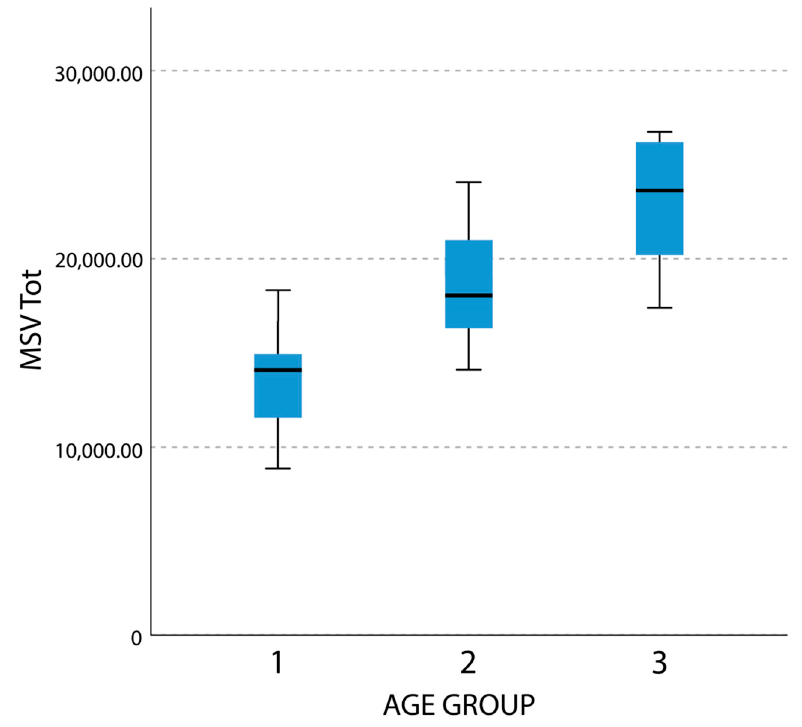
Figure 4. Boxplot representing total maxillary sinus volume (MSV Tot) in female subjects.